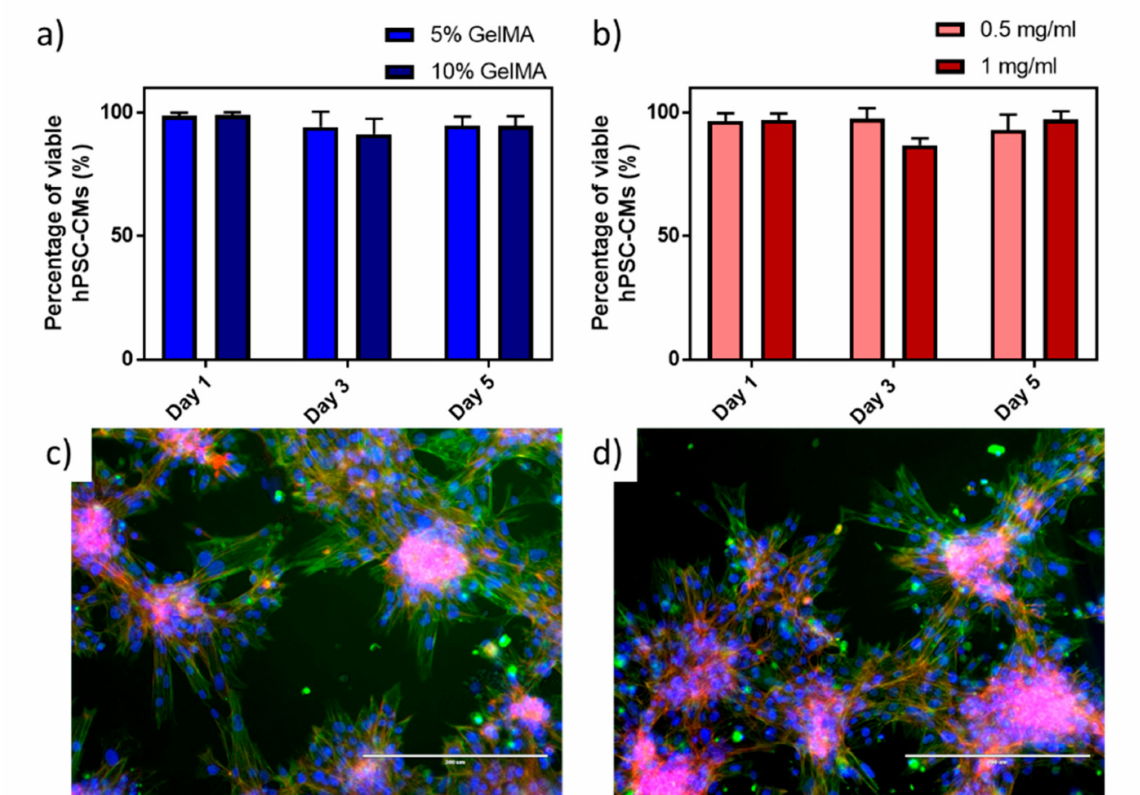
Figure 3. Viability studies performed on human pluripotent stem cell-derived cardiomyocytes (hPSC-CMs) on ( a ) 5% and 10% GelMa and ( b ) 0.5 mm mL − 1 and 1 mg mL − 1 MWCNTs in 5% GelMa. Fluorescence images of immunostained hPSC-CMs after 7 days of culture in ( c ) 5% GelMa and ( d ) 1 mg mL − 1 MWCNTs in 5% GelMa. Nuclei were stained with a Hoechst probe (blue), actin fibres were stained with a phalloidin probe (red), and sarcomeres were immunostained with anti-alpha actinin (green). Scale bar 200 µ